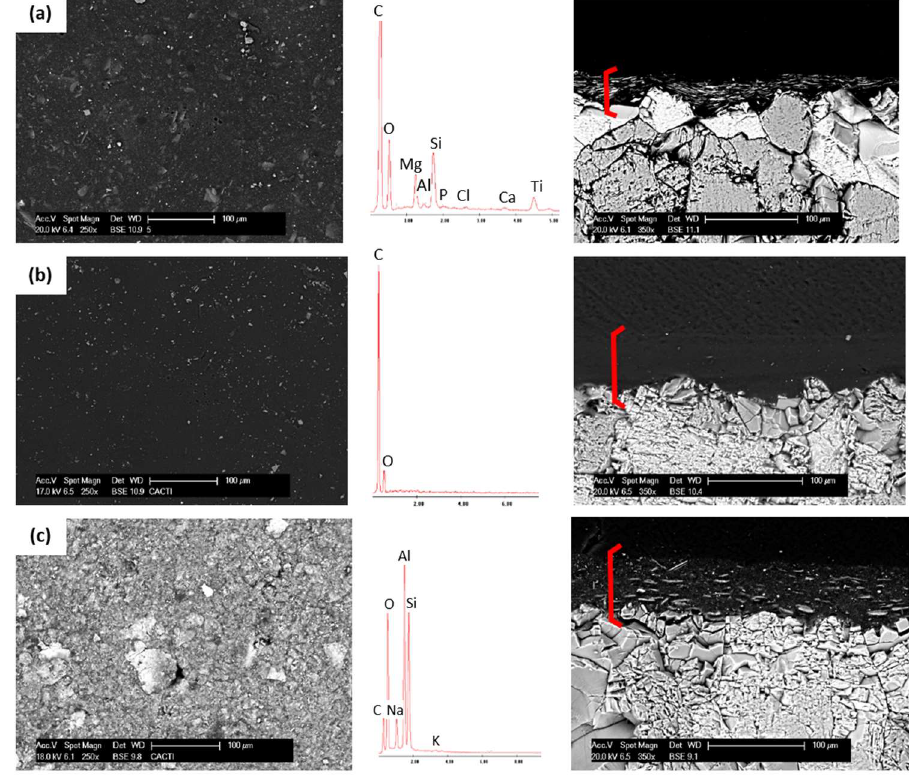
Figure 3. SEM micrographs of the graffiti layers on the granite from the surface ( left ) and the corresponding cross-sections ( right ). EDS spectra of the respective paints are also shown: ( a ) blue; ( b ) black and ( c ) silver graffiti paints.